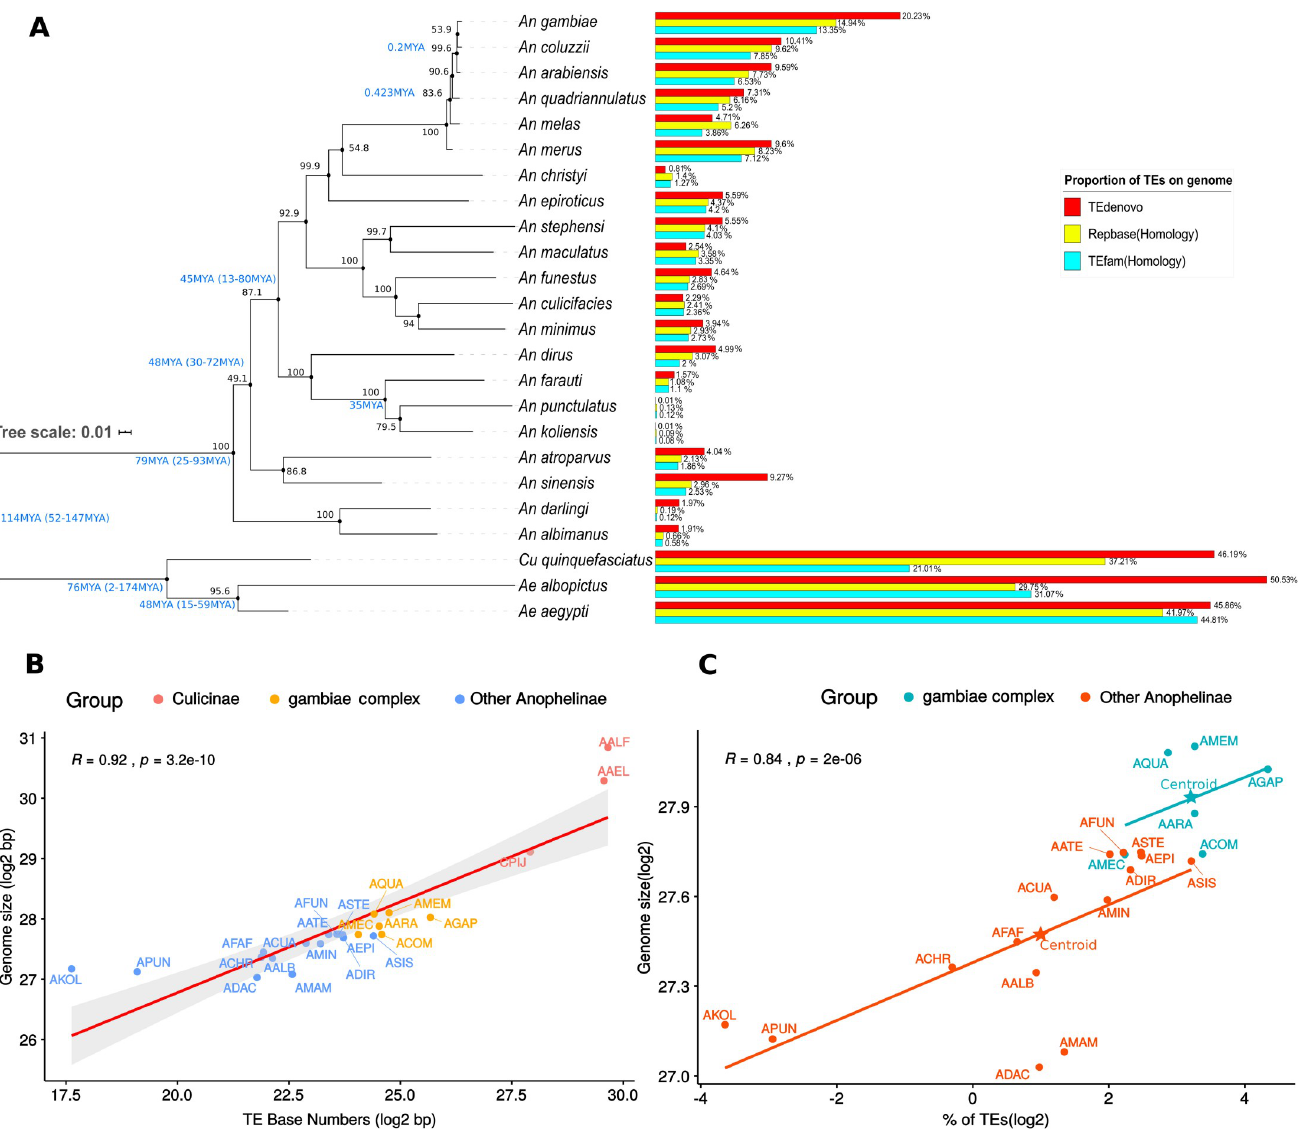
Fig 1. Transposable elements of mosquitoes. (A) A maximum likelihood-based phylogenetic inference, with bootstrap support over the nodes (see Materials and Methods - Genomes Analyzed), reporting the proportion of genome size occupied by transposable elements; blue letters values near bootstrap support represent medium divergence time between species obtained from TimeTree [104], colored horizontal bars represent the proportion of TEs characterized by different methods. (B) Correlation analysis of mosquito genome sizes and TE fraction. Four-letter species abbreviations follow Table 1.